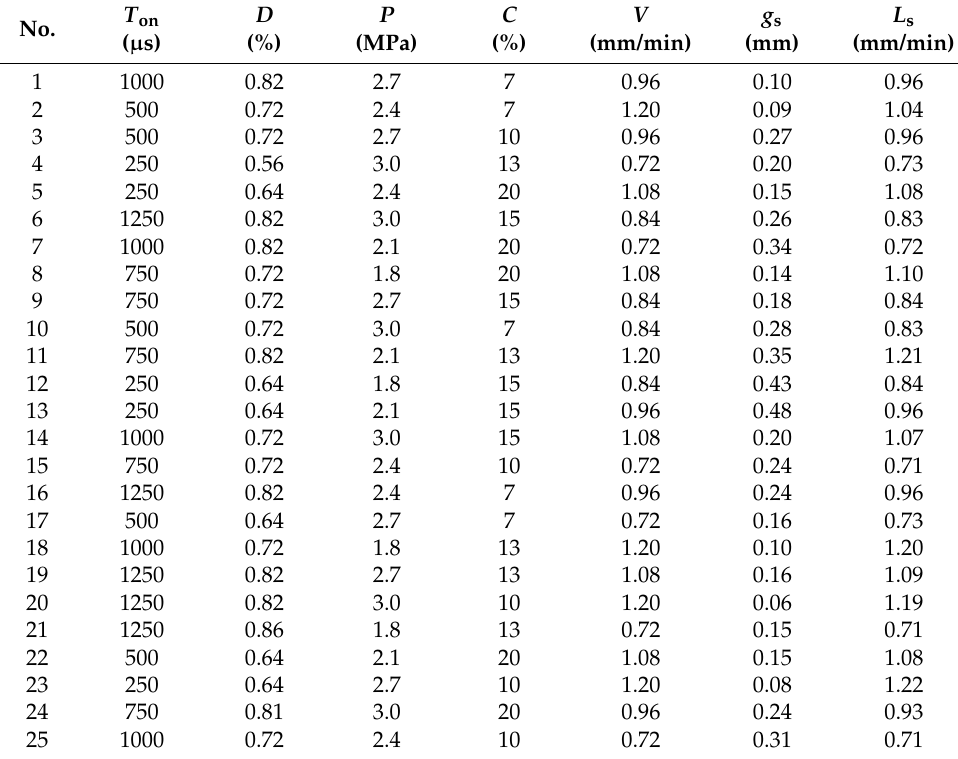
Table 1. Experimental conditions and evaluation